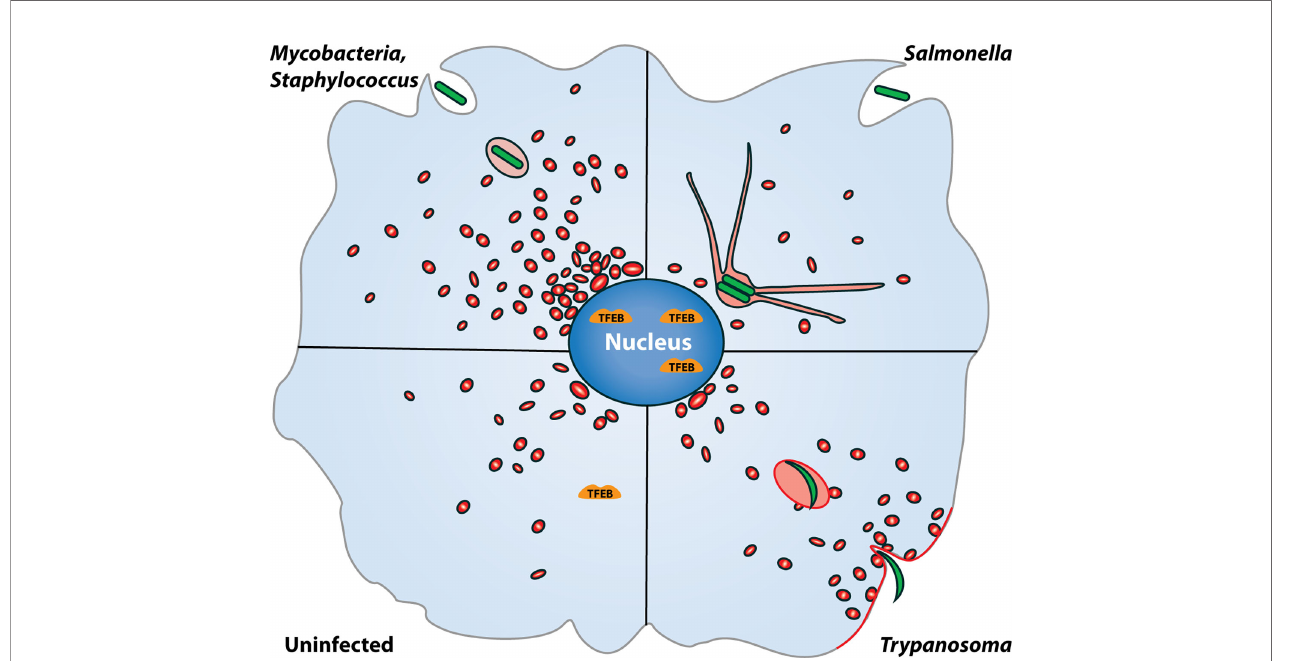
FIGURE 4 | Alteration in the host lysosomal system upon intracellular infections. The host lysosomal alterations in four different pathogenic infections are shown. Lysosomes are shown in red. Mtb and Staphylococcus aureus infection increases the host cellular lysosomes levels compared to uninfected condition, whereas Salmonella infections leads to formation of late endosome/lysosome derived fi lamentous structures. In Trypanosoma infection, lysosomes move toward cell periphery at the site of pathogen entry and fuse with the plasma membrane to facilitate pathogen entry in the host cell. In these infectious condition, i.e Mtb , Salmonella , Staphylococcus and Trypanosoma , transcription factor EB (TFEB) is translocated to nucleus as compared to the uninfected state.